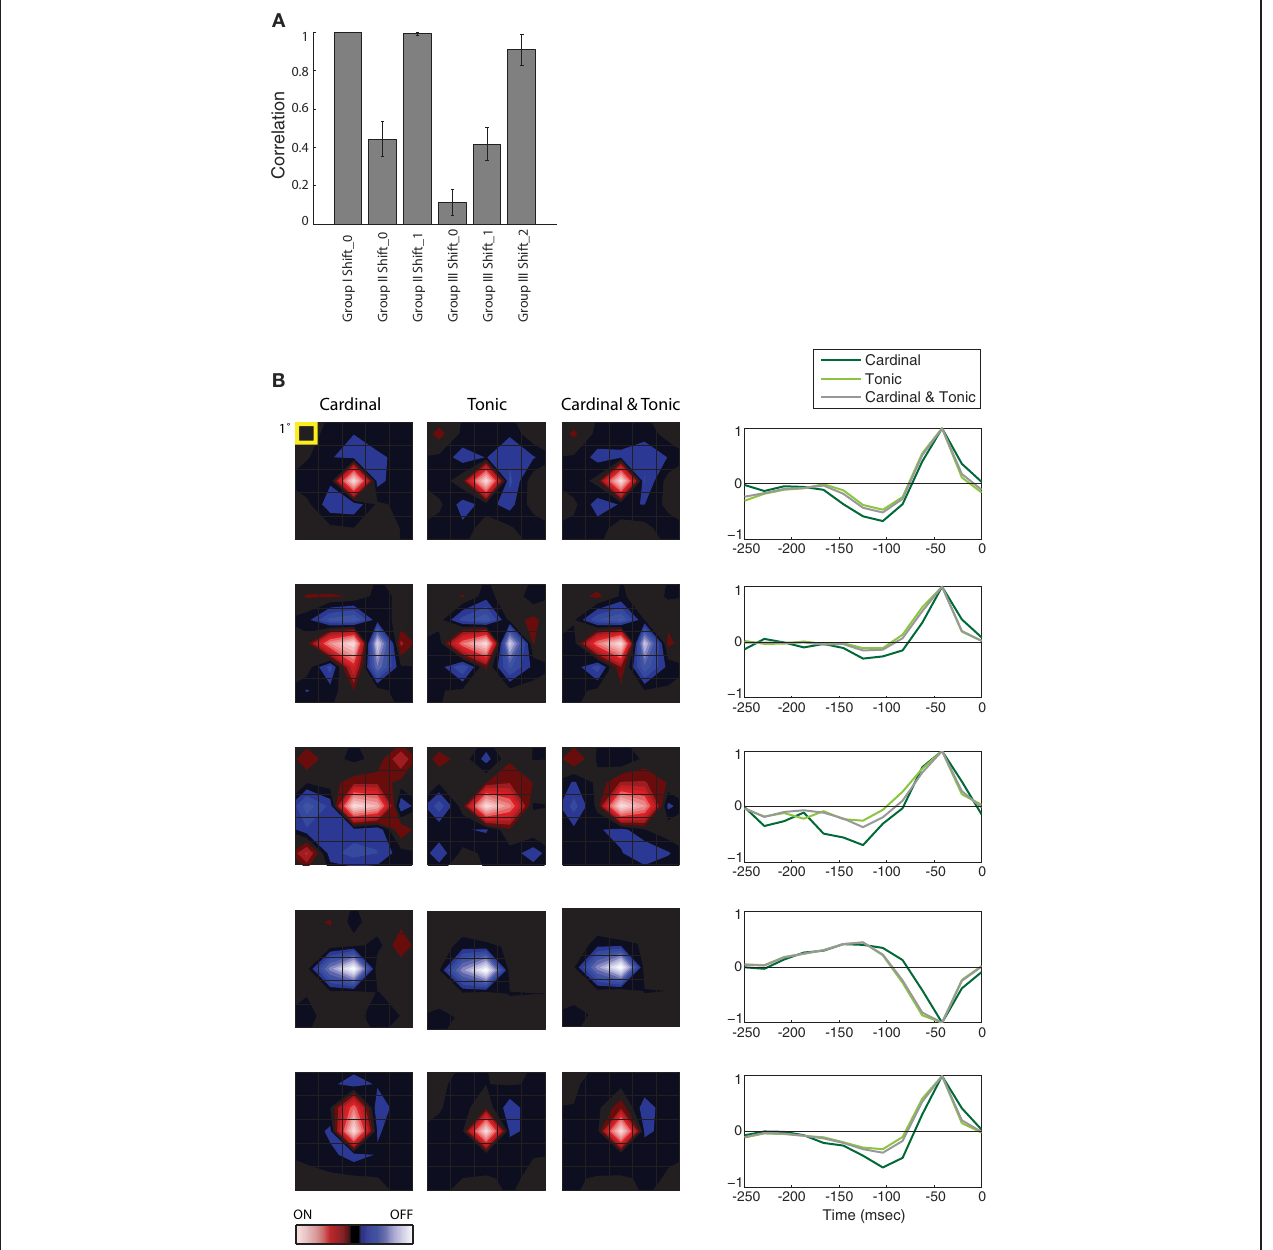
FIGURE 3 | Population analysis of STAs made from burst and tonic spikes. (A) Bar plot of the correlation between the STA for Group I at Shift_0 with itself and the various remaining STAs, as labeled, for 10 cells in the PGN. The height of each bar is the population mean and the error bars span ± one standard deviation. (B) (left) Each row of maps shows three different STAs, generated either from cardinal spikes, tonic spikes, or a mixture of cardinal